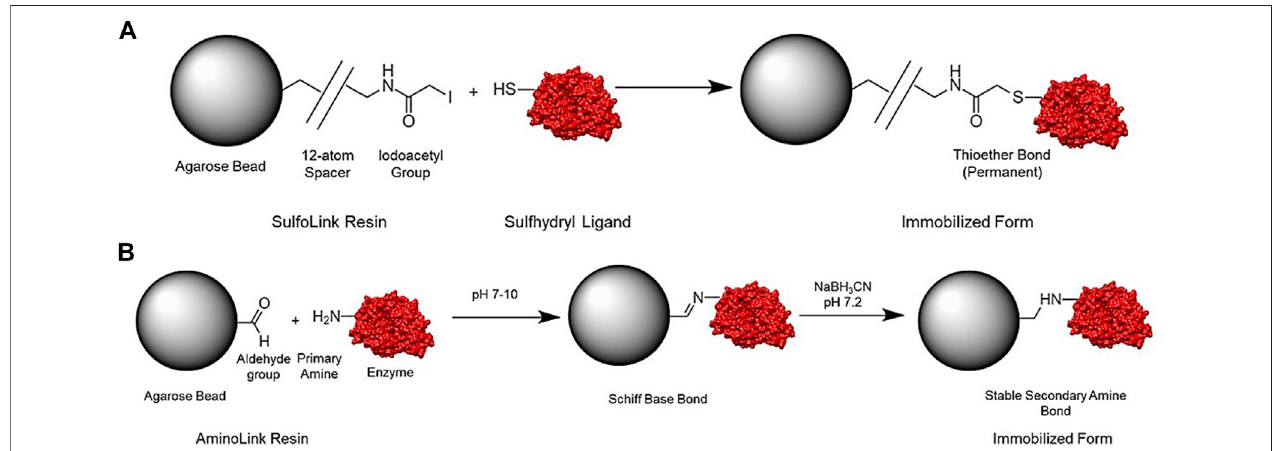
FIGURE 2 | Representation of general structure and reaction scheme for the SulfoLink (A) and AminoLink coupling resin (B) .